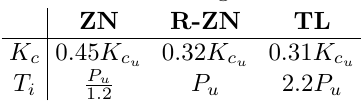
Table 1: PI settings formulas.